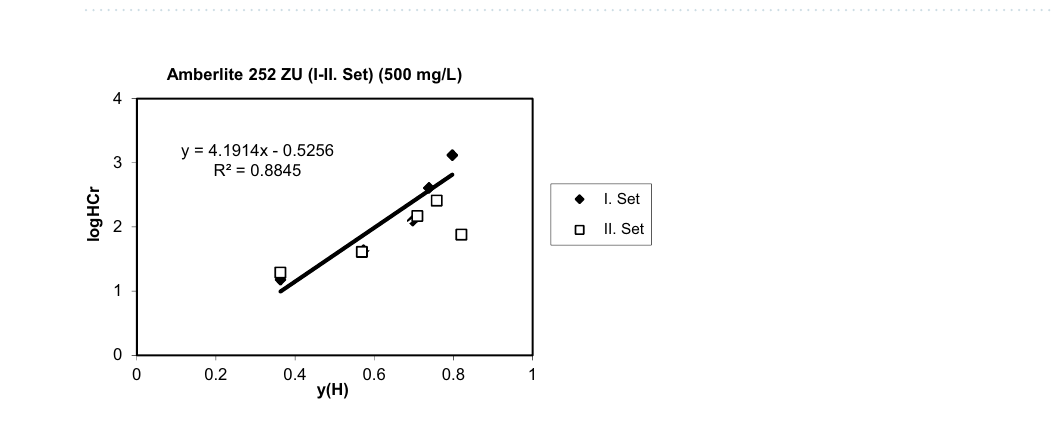
Figure 6. Generalized separation factor for the exchange of H + for Cr 3+ (Initial conc.and pH: 13,259 meq/L, 3.15).